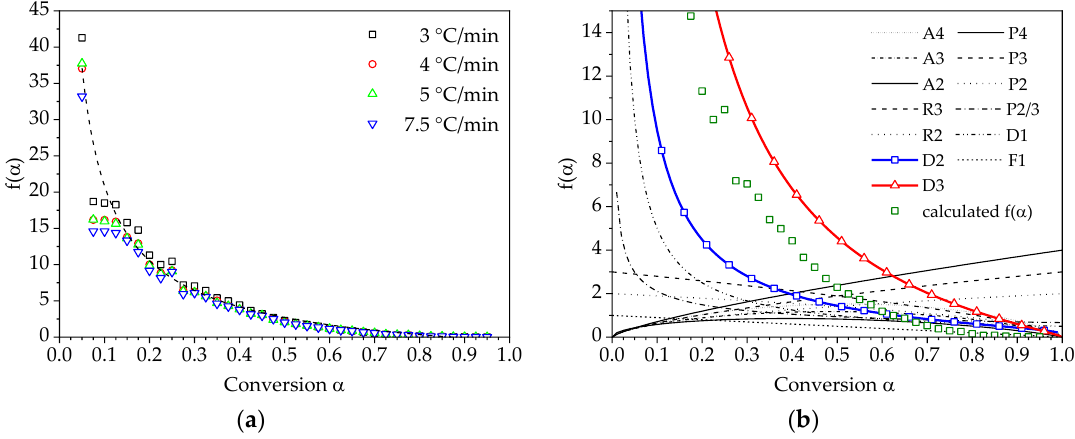
Figure 10. Numerical reconstruction of the reaction model in integral form f ( α ) : ( a ) calculated reaction model using the α − T − dependencies for different heating rates; ( b ) comparison of the calculated model with theoretical models from Table 1